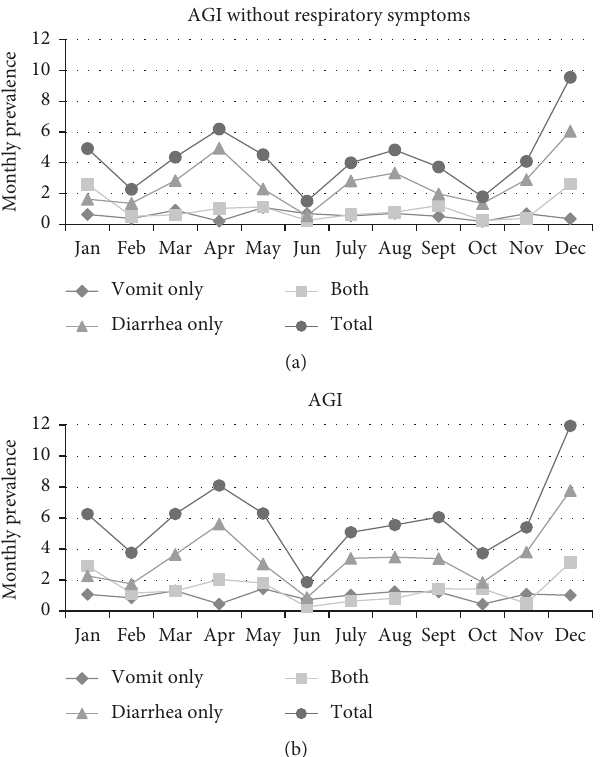
Figure 2: (a) and (b) Monthly prevalence of self-reported AGI by study month and symptoms, 2014-2015. Table 3: Symptoms experienced by respondents reporting acute gastrointestinal illness in Canada, 2014-2015. AGI AGIwithoutrespiratorysymptoms Symptoms